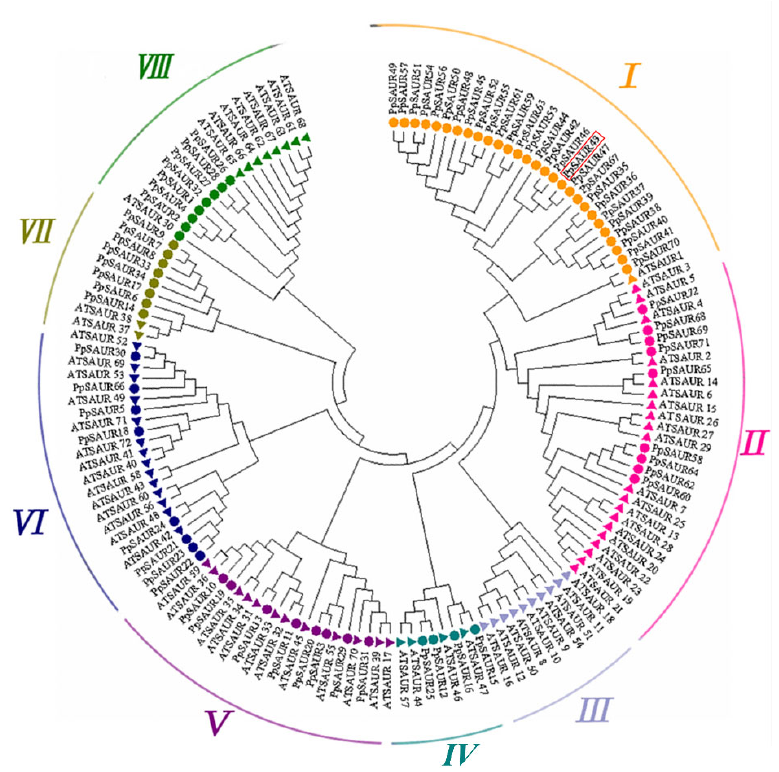
Figure 1. Phylogenetic analysis of SAUR from peaches (PpSAUR) and Arabidopsis (AtSAUR). The unrooted tree was generated using the MEGA7 program by the neighbor ‐ joining method with the following parameters: A bootstrap analysis with 1000 replicates was carried out. Gene IDs corresponding to the peach SAUR proteins listed in the tree are presented in Table 1.